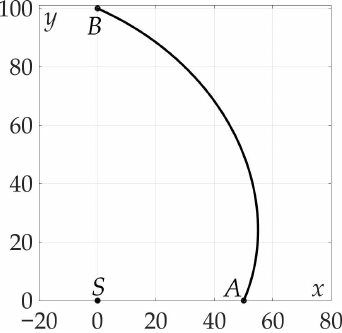
Figure 7. Optimal trajectory on Cartesian plane.